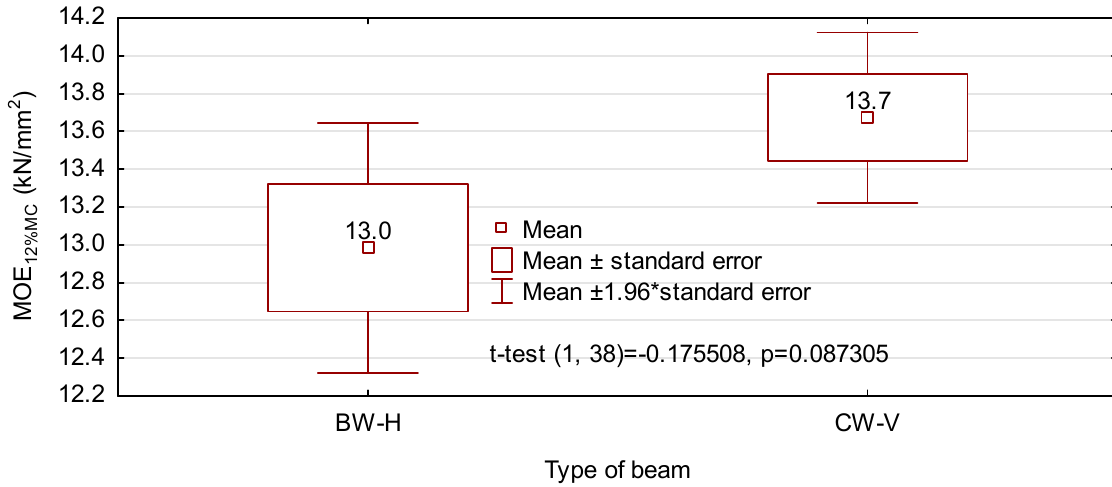
Figure 8. The modulus of elasticity of beams considering moisture content of beams during the test.